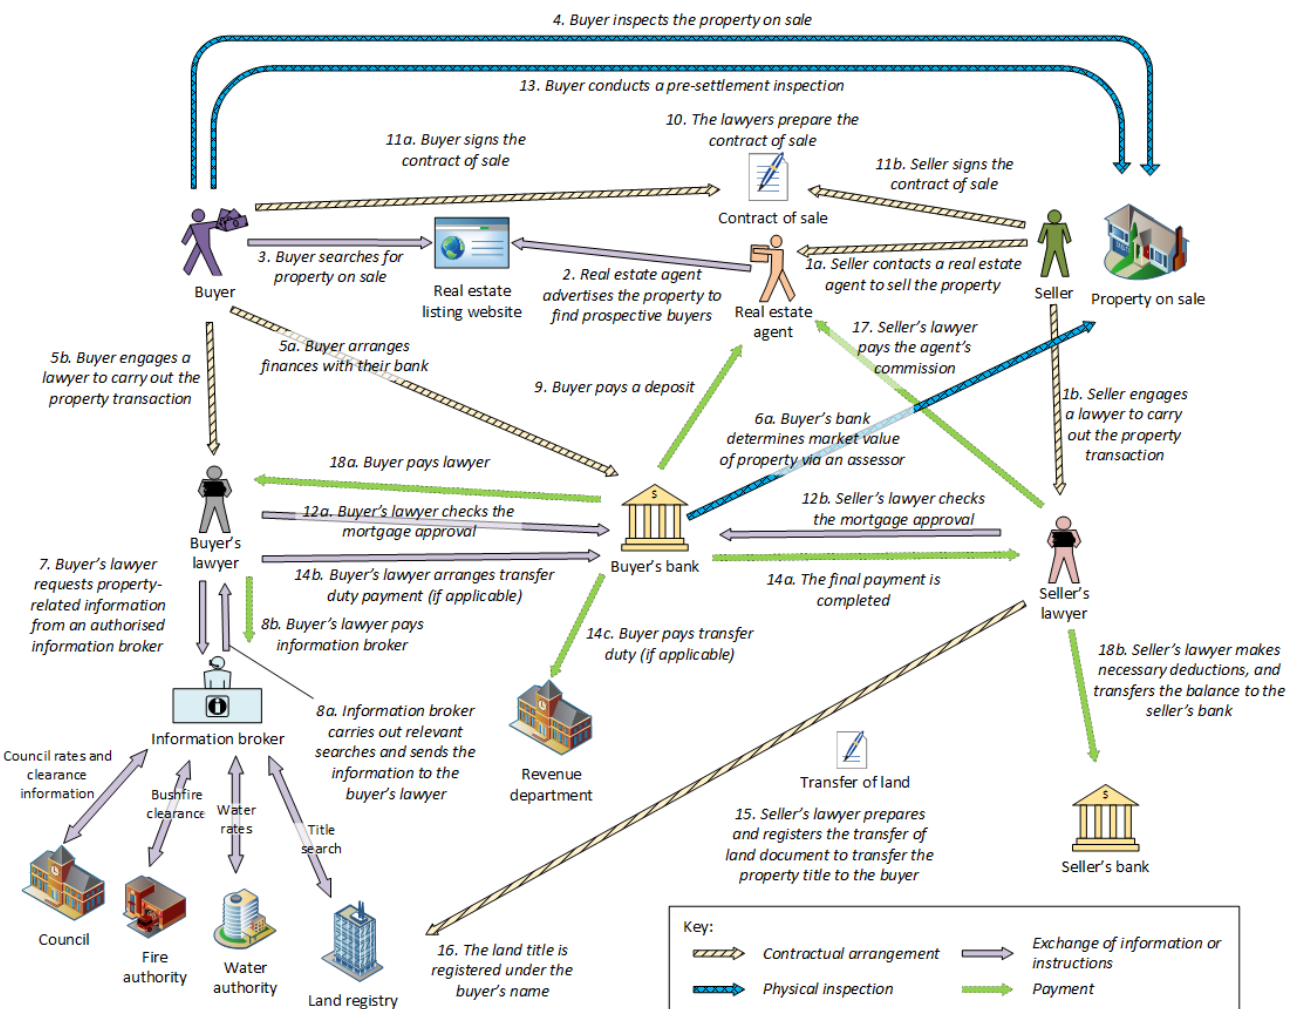
Figure 4. Current process for property transactions.